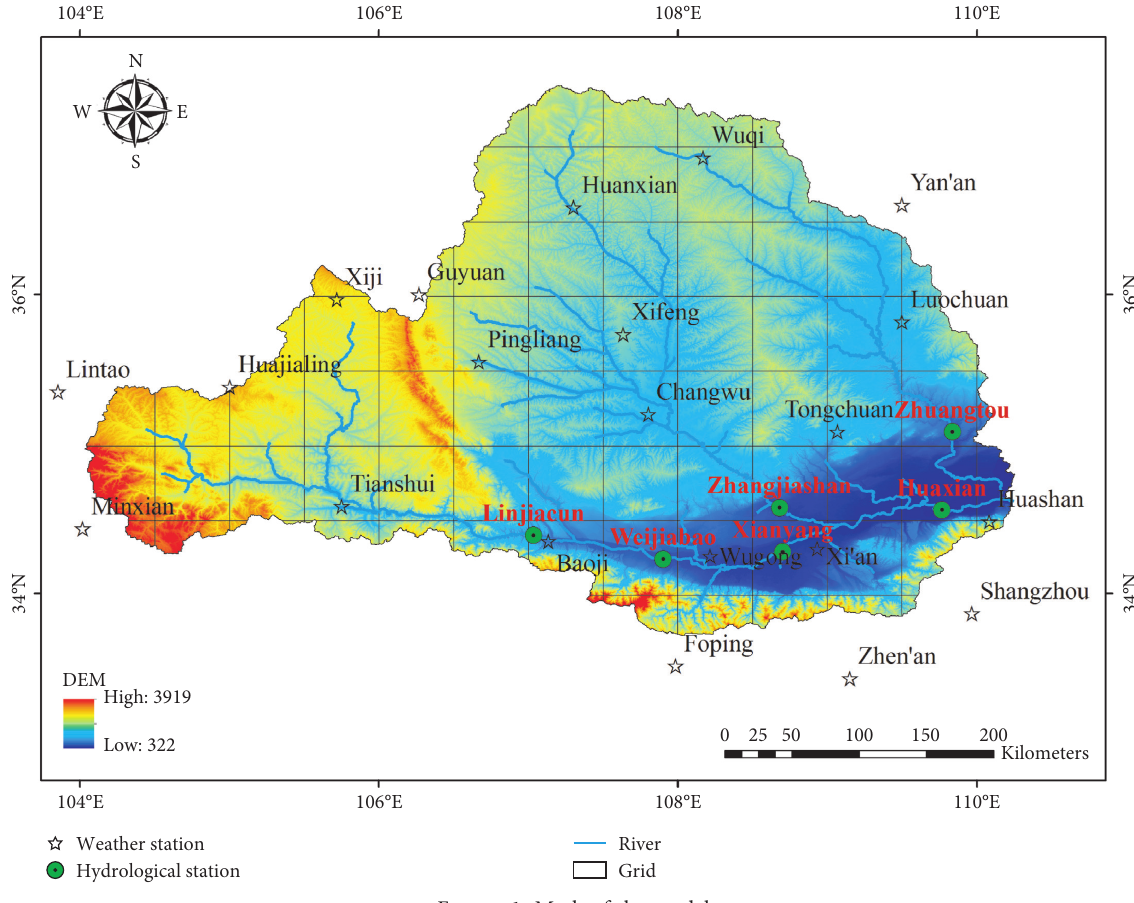
Figure 1: Mesh of the model.